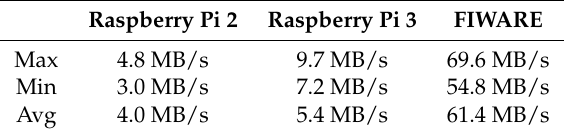
Table 4. Storage average transfer rate using a message size of 220 bytes.